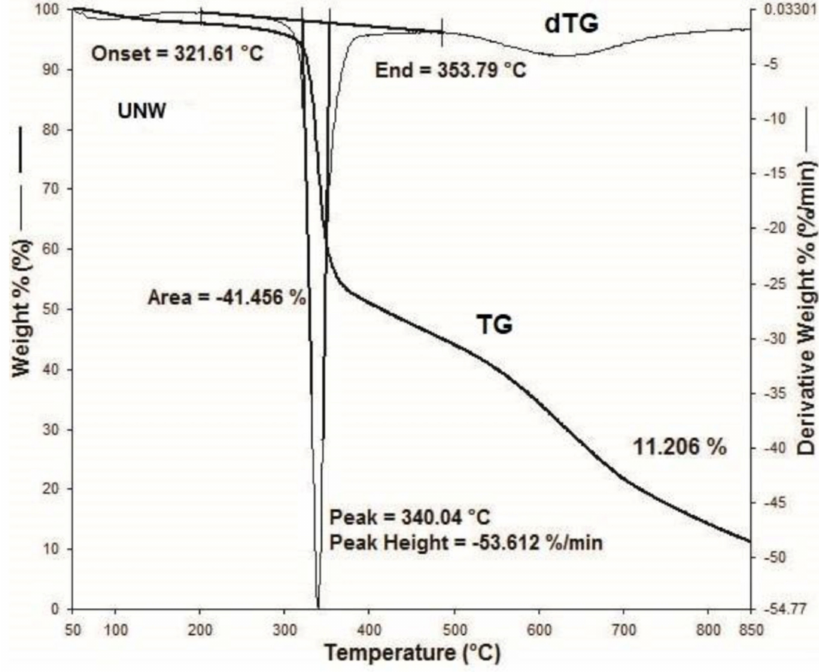
Figure 1. Thermogravimetric analysis of the untreated UNW sample: TG curve, dTG curve.